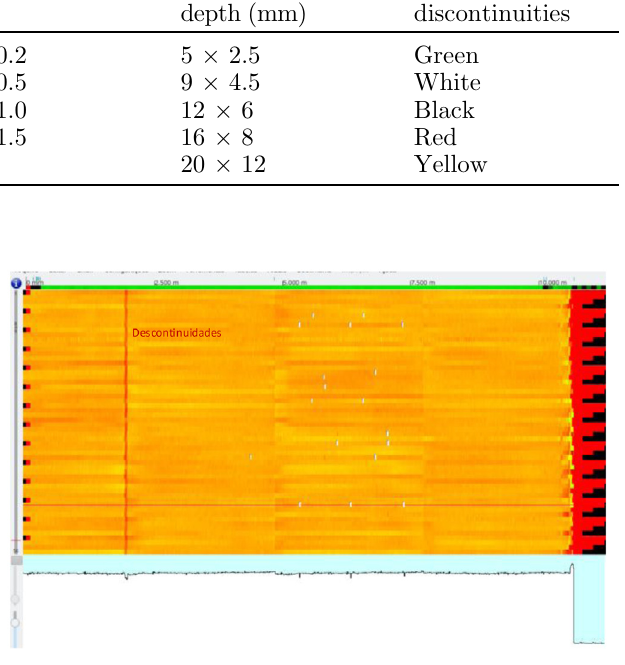
Fig. 13. Image generated by RTScan Software for speed 0.2